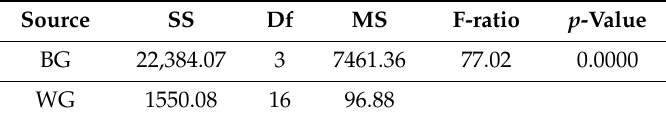
Table 6. ANOVA test for flexural strength of 5 samples.